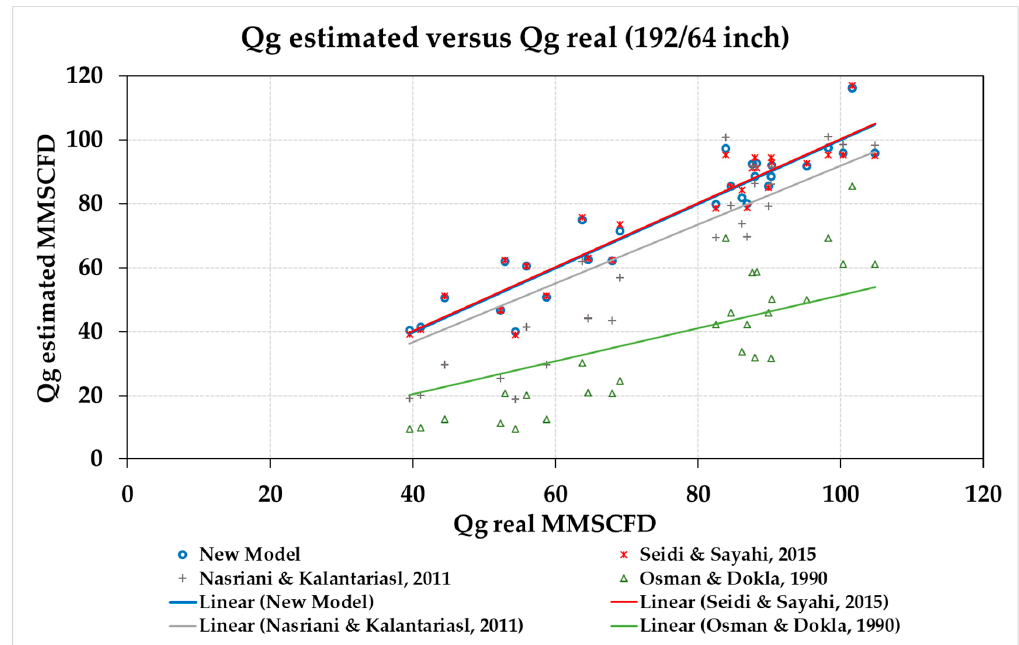
Figure 11 . Estimated gas flow rate versus real gas flow rate (192/64 inch) . Figure 11. Estimated gas flow rate versus real gas flow rate (192 / 64